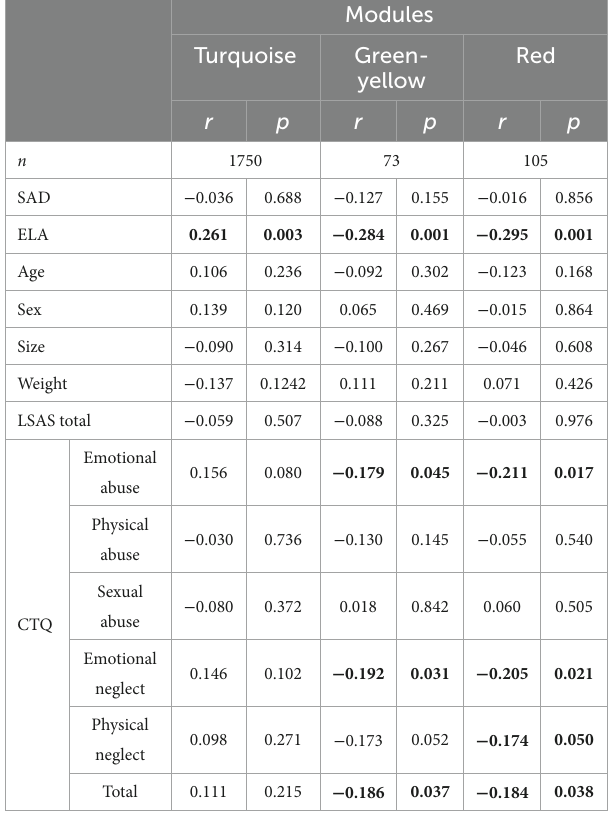
TABLE 2 WGCNA module gene count and correlation coefficients ( r ) and corresponding p -values ( p ) for each variable.